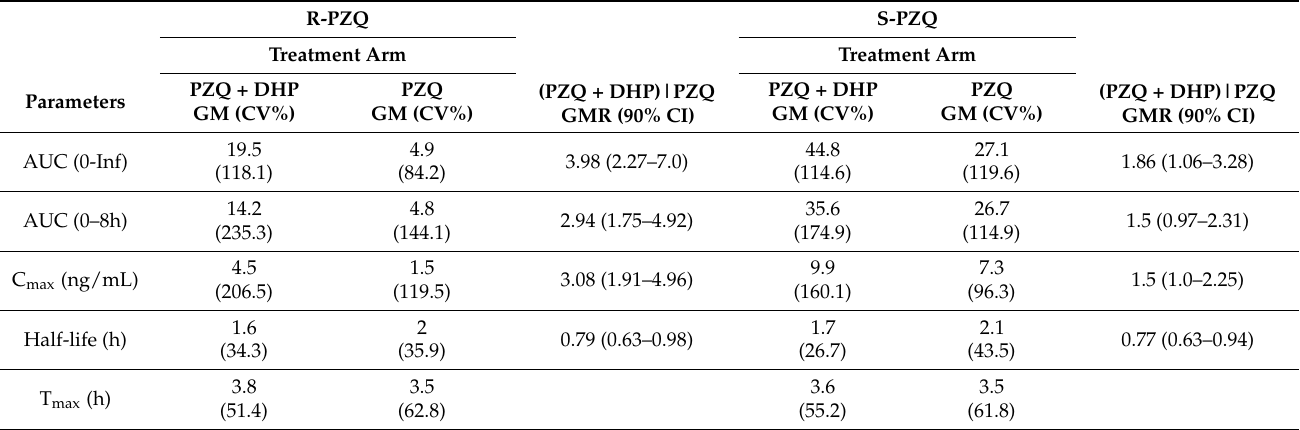
Table 3. Comparisons of pharmacokinetic parameters of R-PZQ and S-PZQ between PZQ + DHP and PZQ treatment arms.